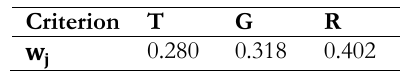
Table 21. The weight of the sub-criteria after